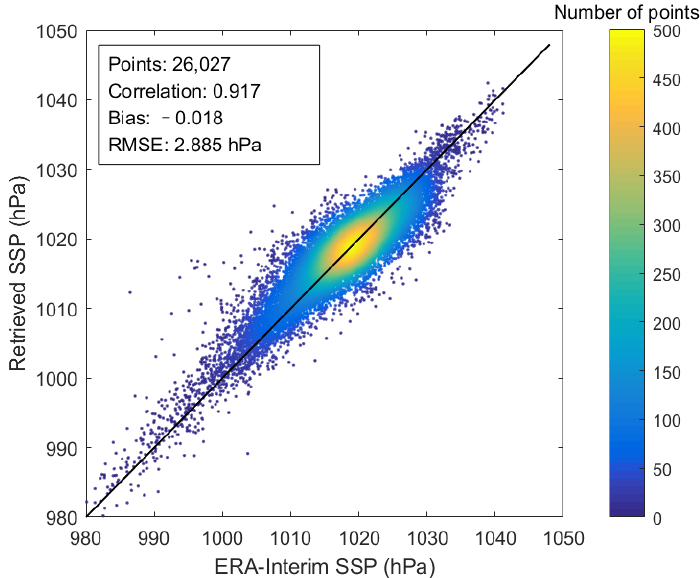
Figure 9. The retrieval result of SSP using the observed brightness temperatures of all channels of MWTS-II.